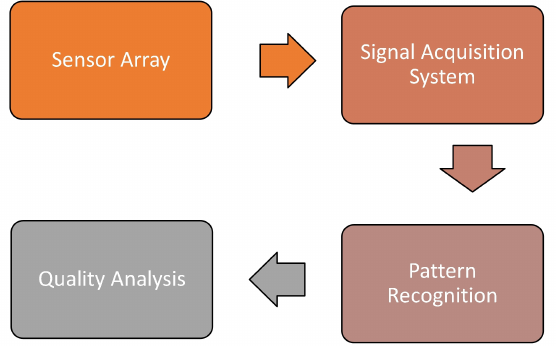
Figure 4. Constructional block diagram of an electronic tongue.